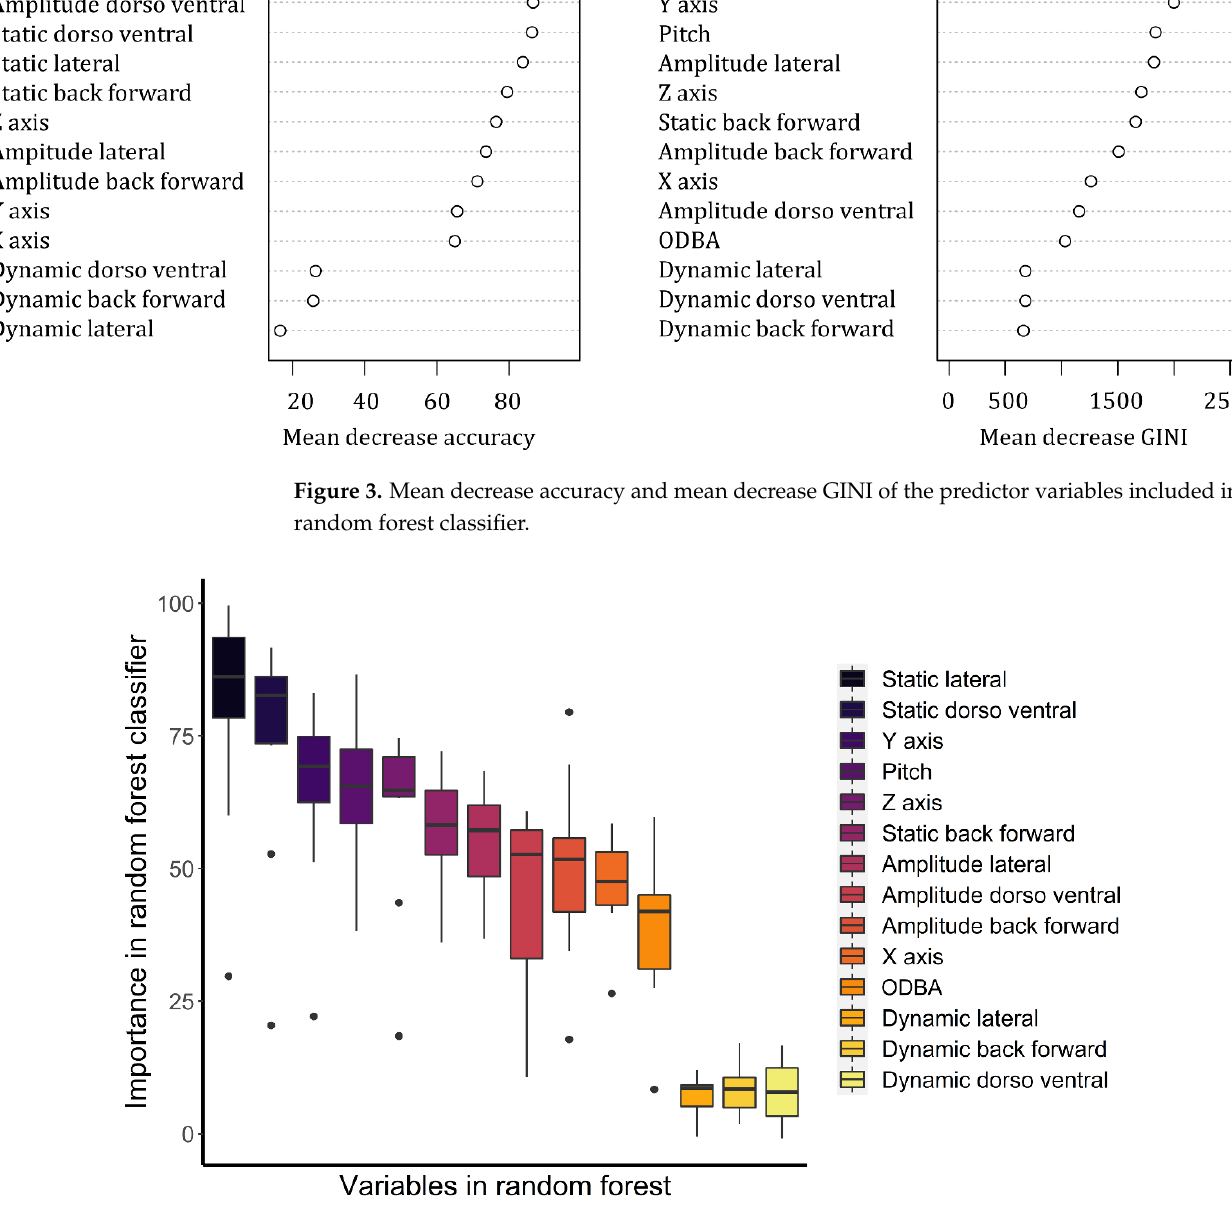
Figure 4. Box plots of the importance as a classifier of the variables included in the random forest. Values are medians, quartiles, and ranges considering the ten behaviours tested. Points are outliers.